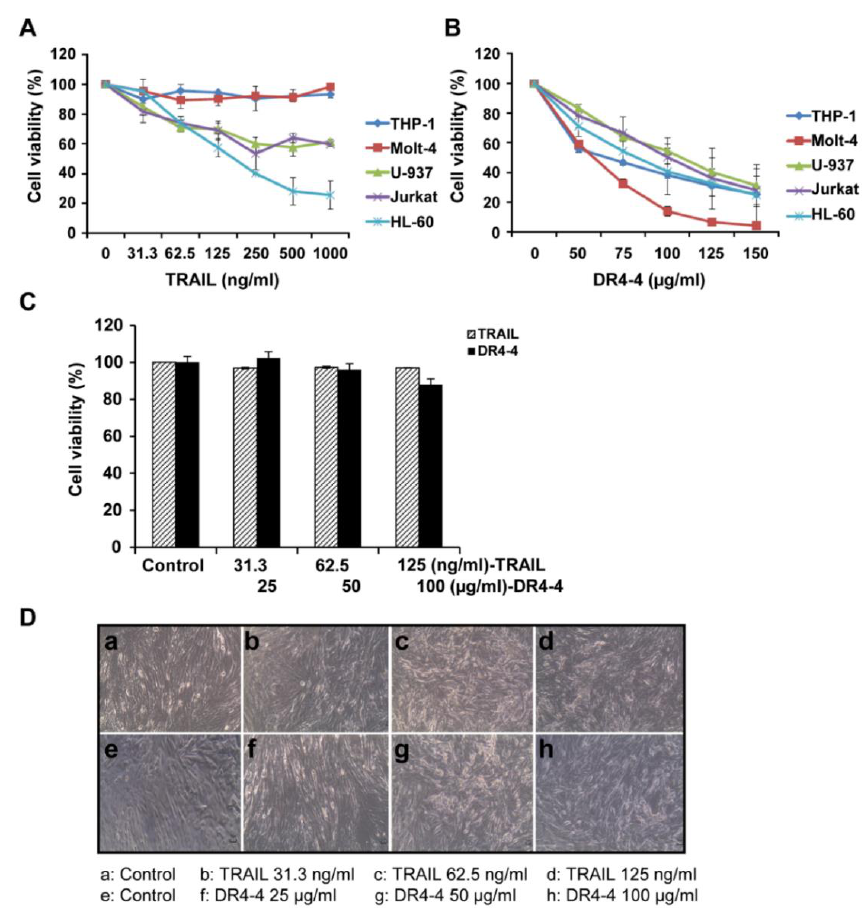
Figure 3. Specific cytotoxic e ff ects of DR4-4 Fab on cancer cells. Cells (2.5 × 10 4 ) were treated with the indicated concentrations of TRAIL ( A ) or DR4-4 Fab ( B ) for 48 h. ( C ) Viability (as assessed by MTT assay) of normal human fibroblasts (1 × 10 5 ) treated with TRAIL or DR4-4 Fab for 48 h. ( D ) Cell morphology of normal human fibroblasts treated with TRAIL or DR4-4 Fab for 48 h was evaluated by phase contrast microscopy at 100×. Data presented as mean ± standard deviation.